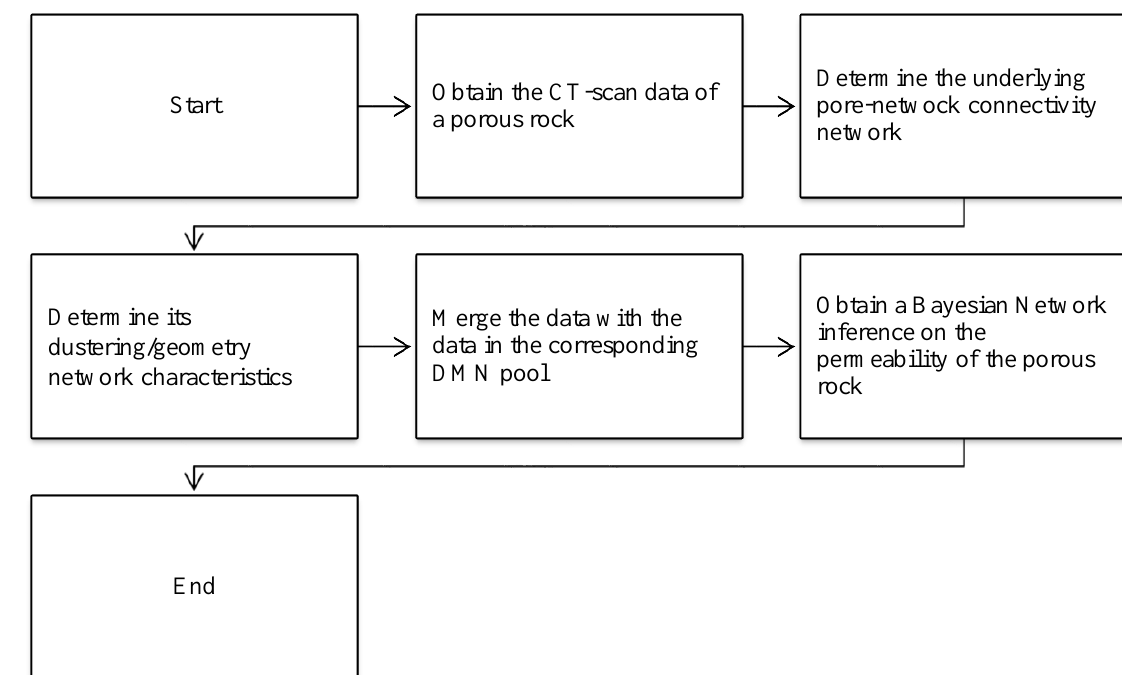
Figure 1. The flowchart of the proposed Bayesian quantification